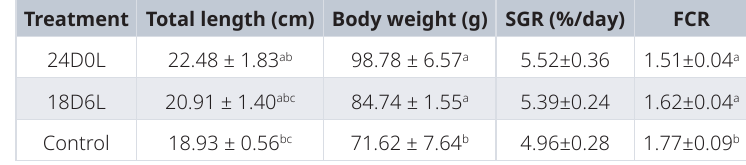
Table 1. Total length and body weight of Pangasionodon hypophthalmus reared under manipulated photoperiod at the end of the experiment (8 week treatment period).